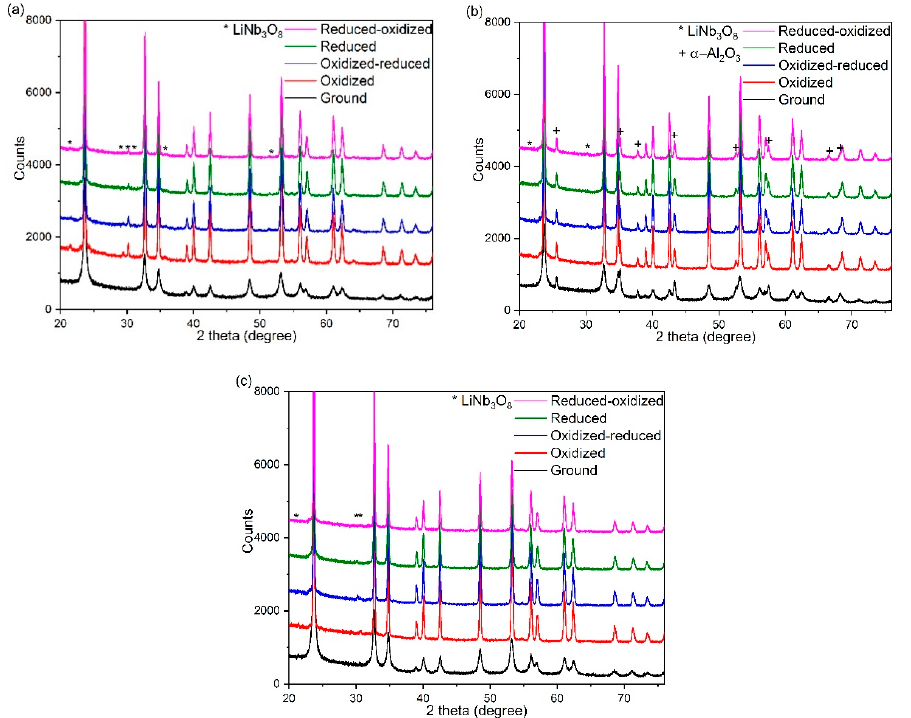
Figure 2. Diffraction patterns of Lithium niobate (LN) ground in different vials, stainless steel ( a ), alumina ( b ), and tungsten carbide ( c ). The unmarked peaks are the reflections of LiNbO 3 .